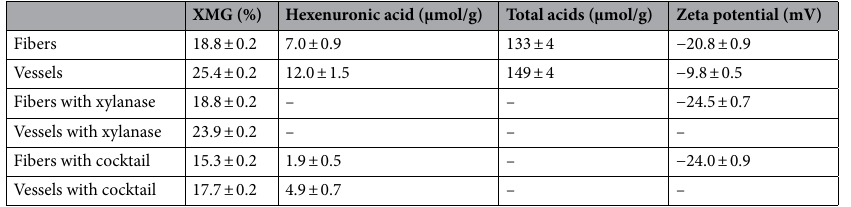
Table 2. Chemical analysis and zeta potential (Mütek SZP-06). XMG xylose, mannose, and galactose content.